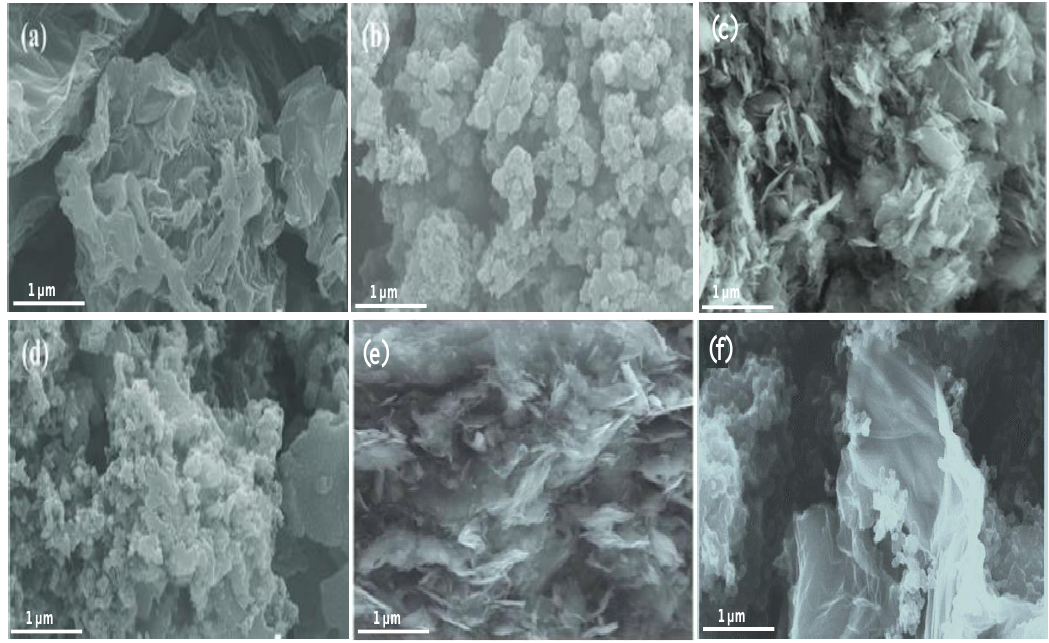
Figure 1. Representative SEM micrographs of raw GO ( a ), neat PANI ( b ), HDI-GO 6 ( c ), PANI / HDI-GO 6 (10 wt %) ( d ), HDI-GO 1 ( e ), and PANI / HDI-GO 1 (10 wt %) ( f ).